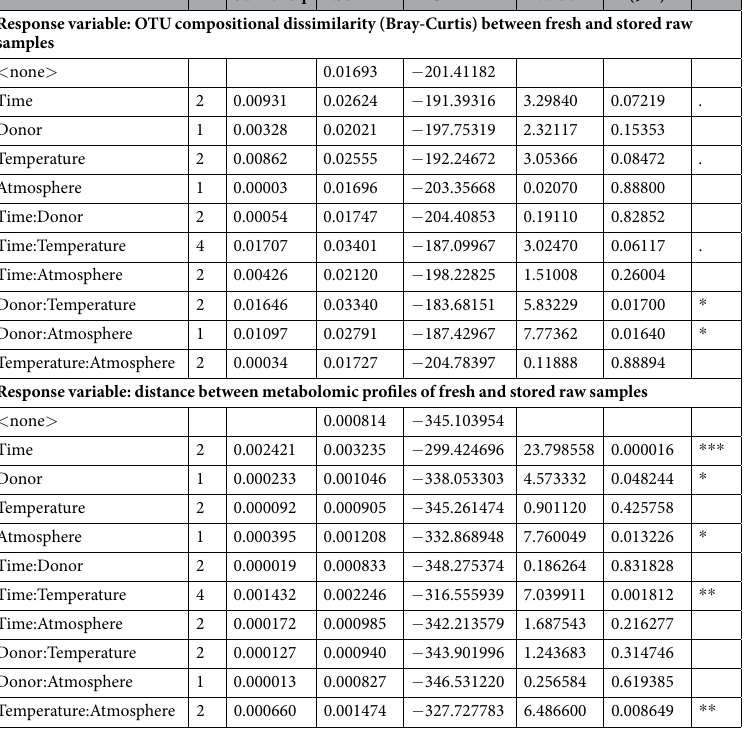
Table 1. Results of the two-way ANOVA. Impact of short-term storage conditions on raw samples. Signif. codes: 0 ‘ *** ’ 0.001 ‘ ** ’ 0.01 ‘ * ’ 0.05 ‘.’ 0.1 ‘ ’